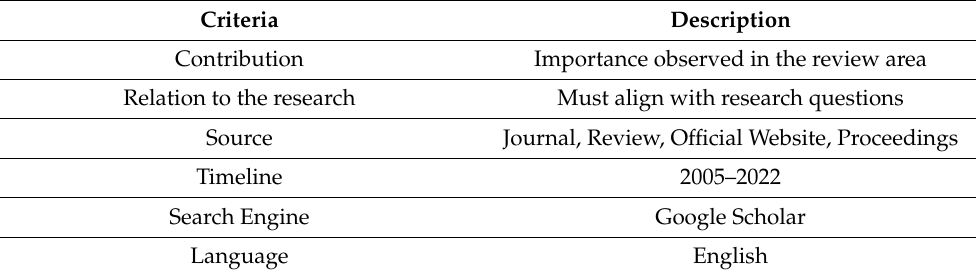
Table 2. Search Criteria of the study.